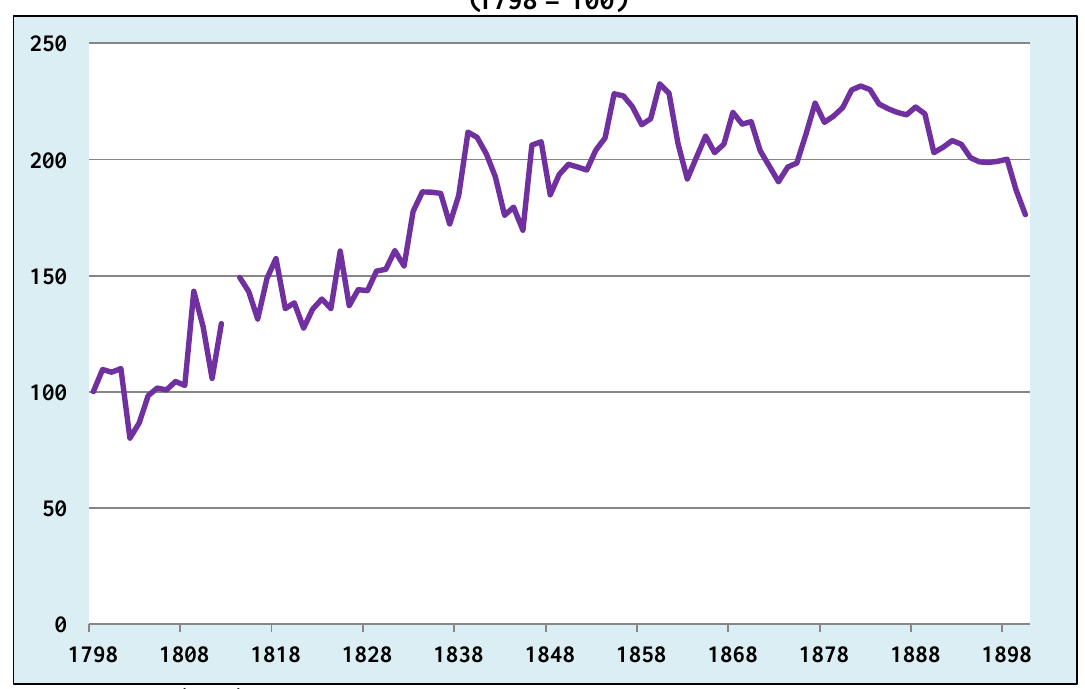
Figure 2: Terms of Trade for Primary Products